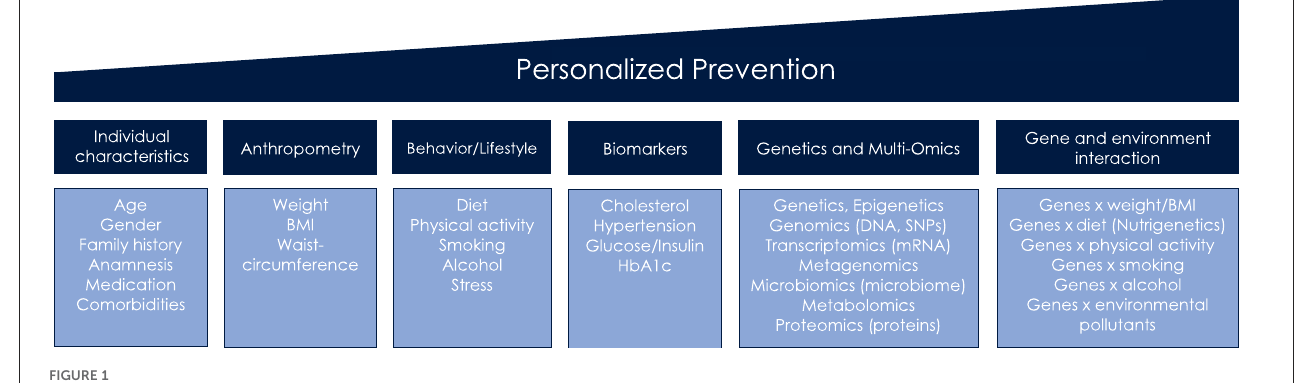
FIGURE1 Key components of personalized